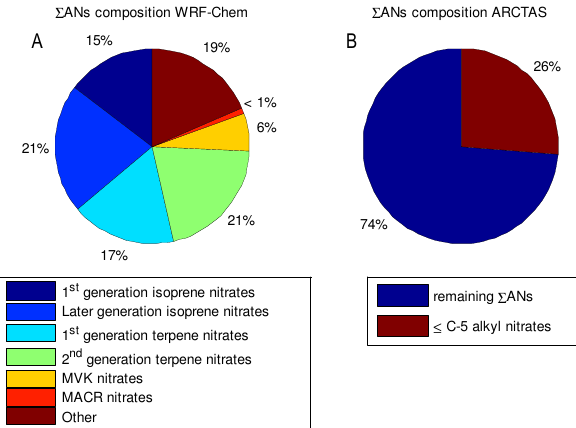
Fig. 5. (a) The 6 ANs composition predicted by WRF-Chem along the flight track at altitudes less than 2km. (b) The 6 ANs composi- Figure 5 a) The Σ ANs composition predicted by WRF-Chem along the flight track at altitudes 3 tion during ARCTAS for the same altitudes. The ≤ C5 nitrates were less than 2 km. b) The Σ ANs composition during ARCTAS for the same altitudes. The ≤ C5 4 measured in the whole-air samples and the total was measured using nitrates were measured in the whole air samples and the total was measured using TD-LIF. 5 TD-LIF. Details are in Browne et al. Details are in Browne et al. (2013). 6